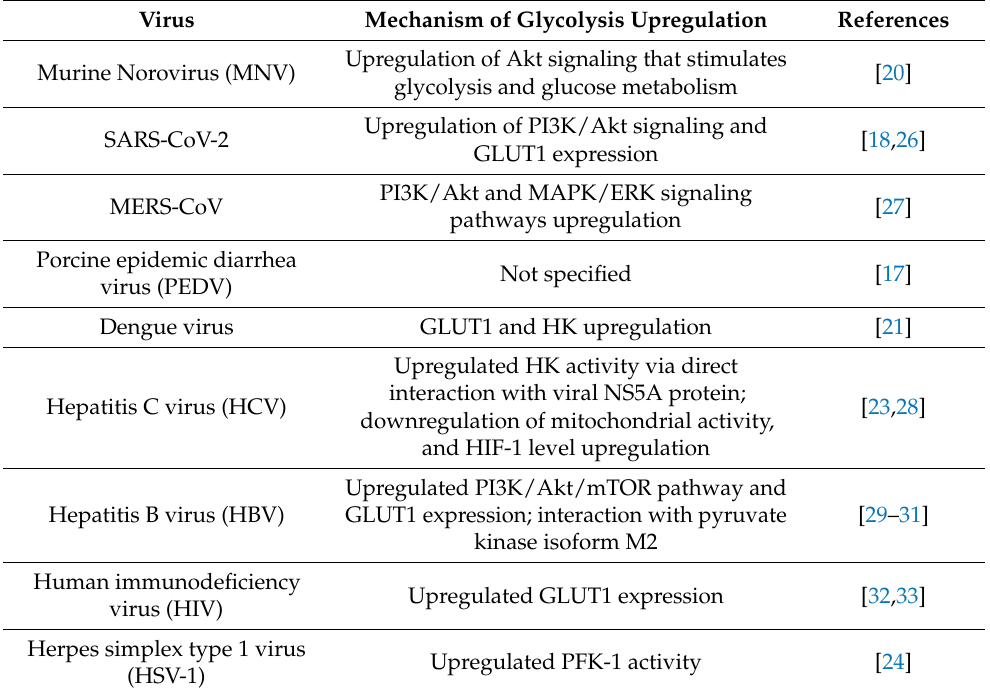
Table 1. Viruses upregulating host cell glycolysis as a mechanism required for their optimal replication.